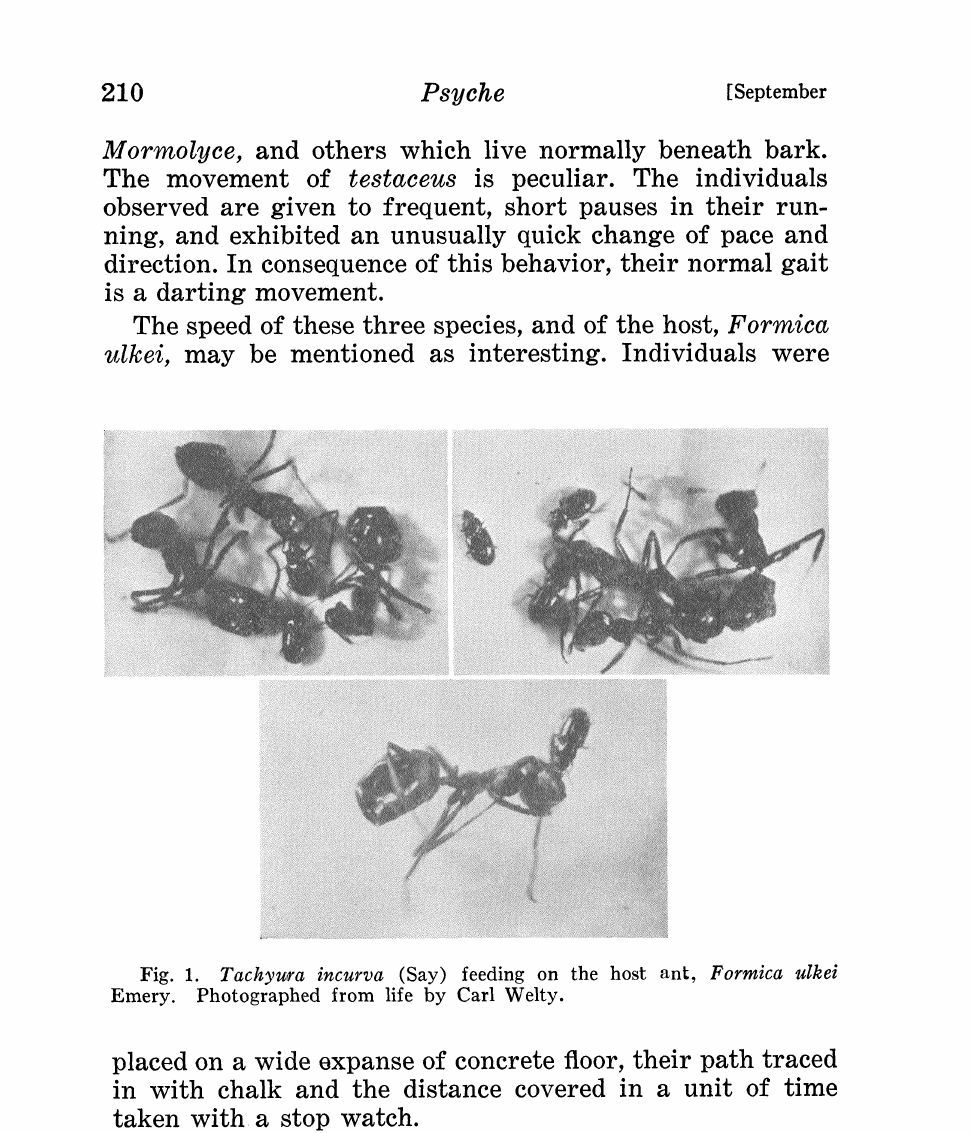
Fig. 1. Tachyura incurva (Say) feeding on the host ant, Formica ulkei Emery. Photographed from life by Carl Welty. placed on a wide oxpanse of concrete floor, their path traced in with chalk and the distance covered in a unit of time taken with. a stop